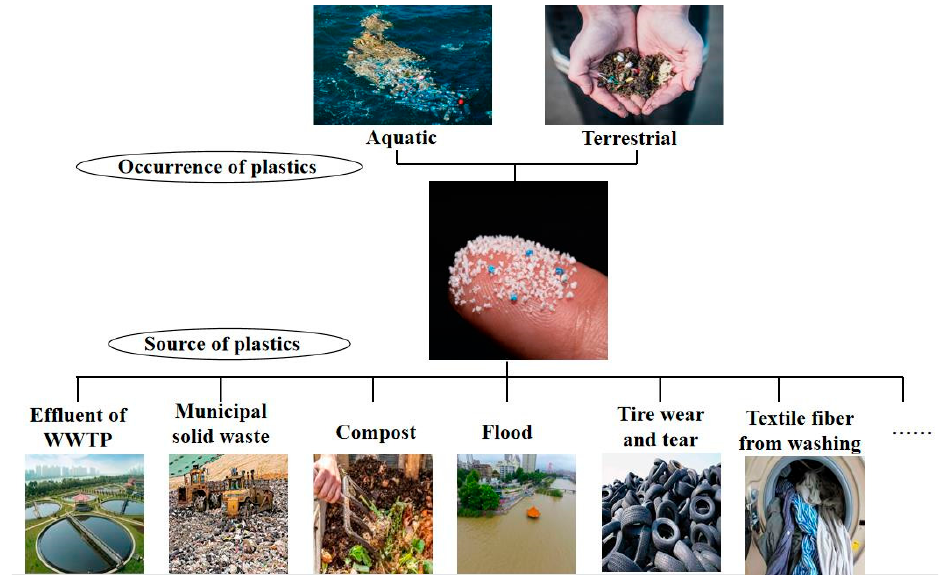
Figure 1. Occurrence and sources of MPs in the environment.